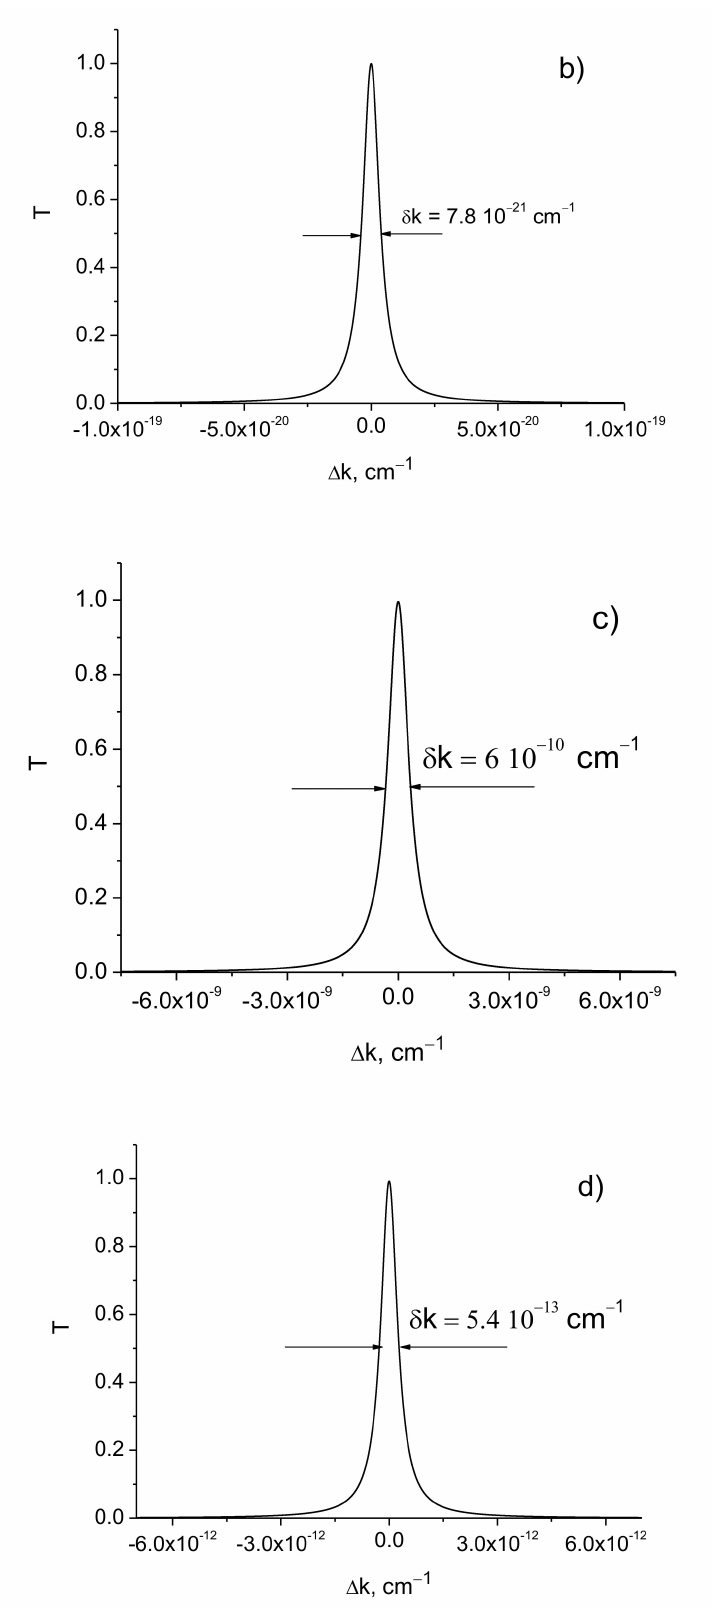
Figure 3. Transmission coefficients as function of the detuning of the resonator. L = 0.75 cm, d = 1